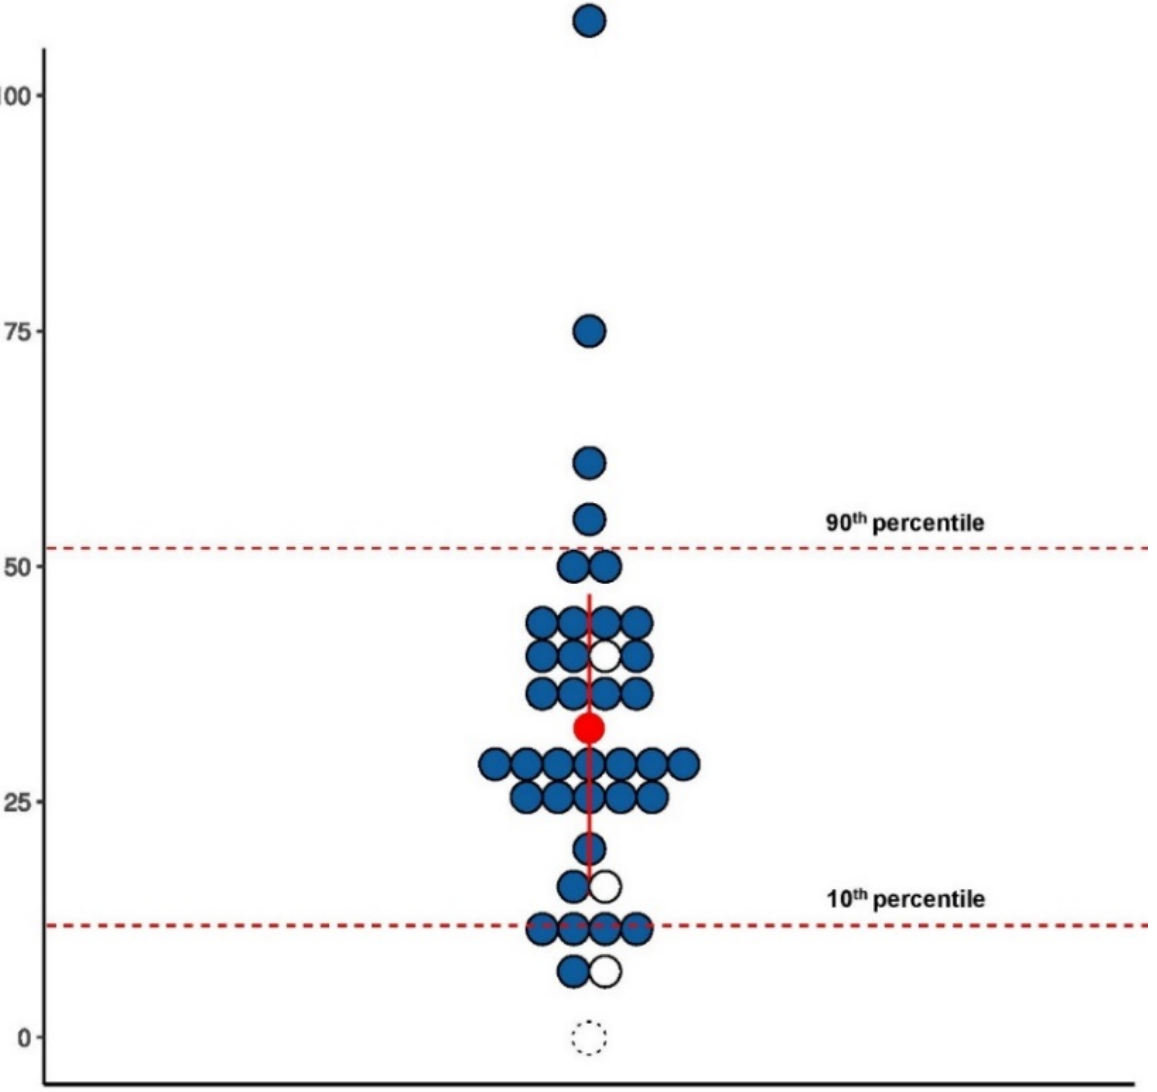
Figure 3. Distribution of total app prescription per general practitioner (GP). The red dot indicates the median (30 apps), the white dots indicate the participants who dropped out, and the dashed circle represents the participant who never